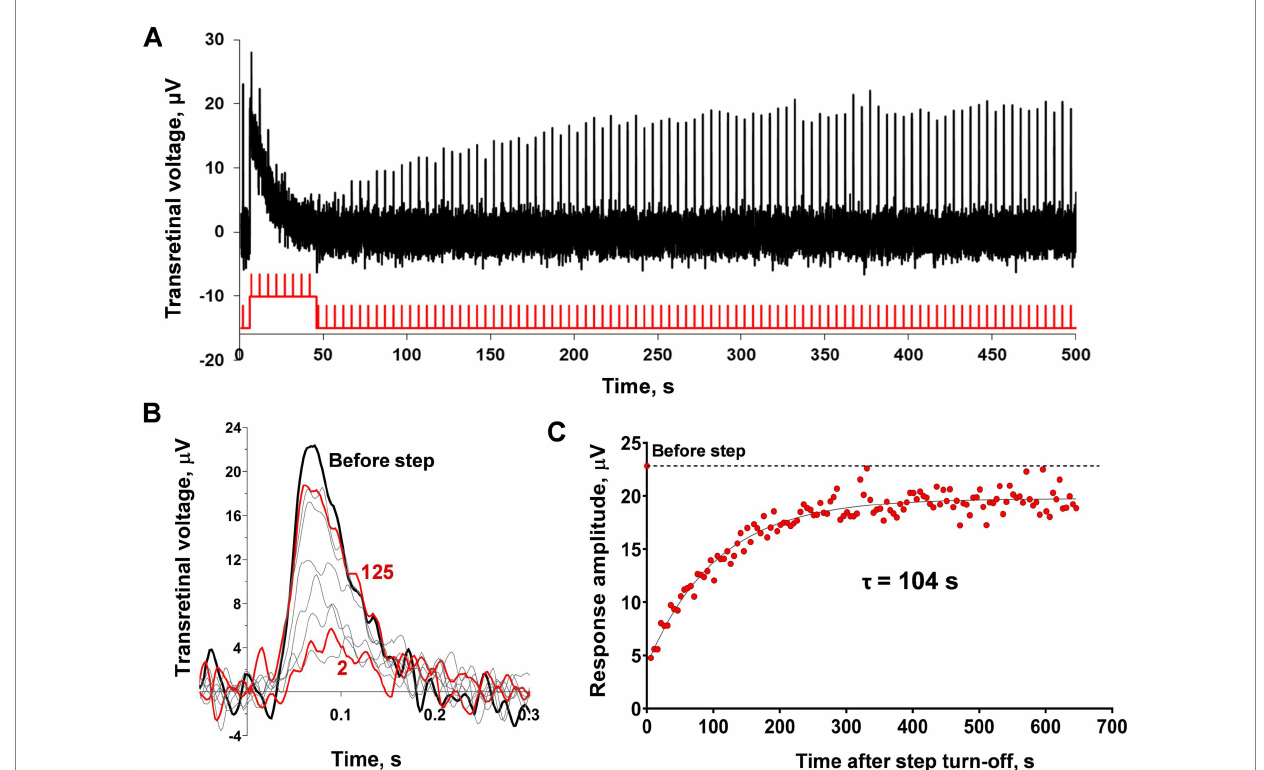
FIGURE 6 Analysis of sensitivity recovery after the light step in C. gibelio red-sensitive cones. (A) Example representative of the ERG-recordings from the isolated C. gibelio retina after application of 10 mM sodium aspartate and the continuous green background light (33,600 photons· μ m − 2 ·s − 1 ). The testing step and brief flashes were done with red light (see Material and Methods) with intensities of 3.4×10 5 photons· μ m − 2 for flashes and 1.08×10 7 photons· μ m − 2 ·s − 1 for step. (B) Single responses cut from the recordings (A) and superimposed for shape comparison: black bold line indicates the pre- step response, red bold lines indicate the first response after the step and the final response after the step during the observation period (626 s after the step turn-off), thin gray lines indicate several intermediate responses. (C) Evaluation of the rate of response amplitude recovery with an exponential function. For reference, the point plotted at time zero and the dashed line illustrates the pre-step